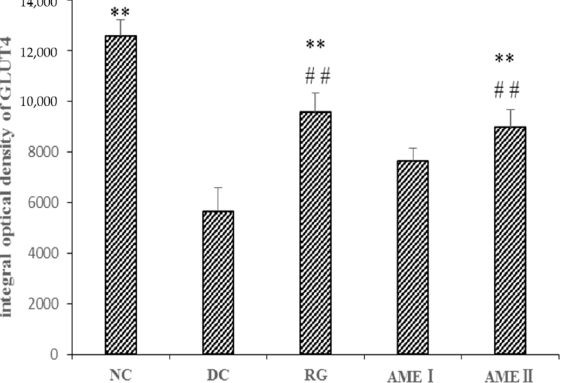
Figure 5. The effect of AME on GLUT4 immunoreactivity in the skeletal muscle tissue of diabetic mice. ( n = 10).